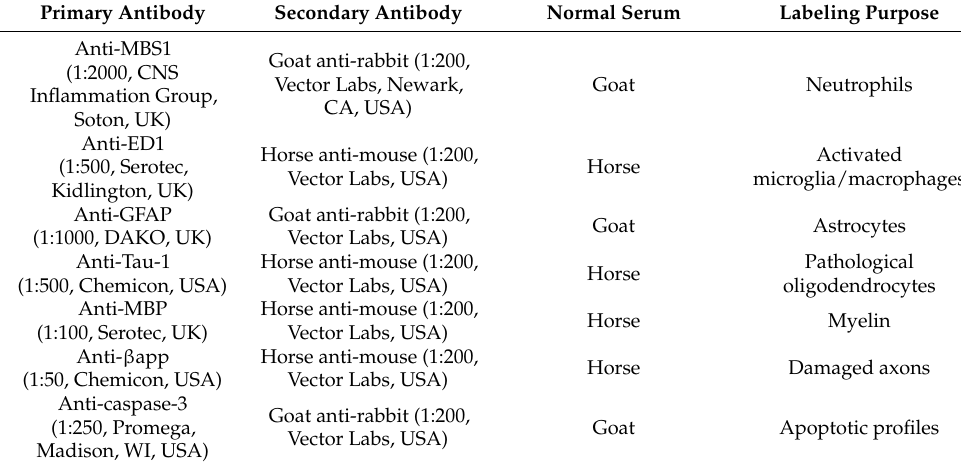
Table 1. Antibodies and normal serums